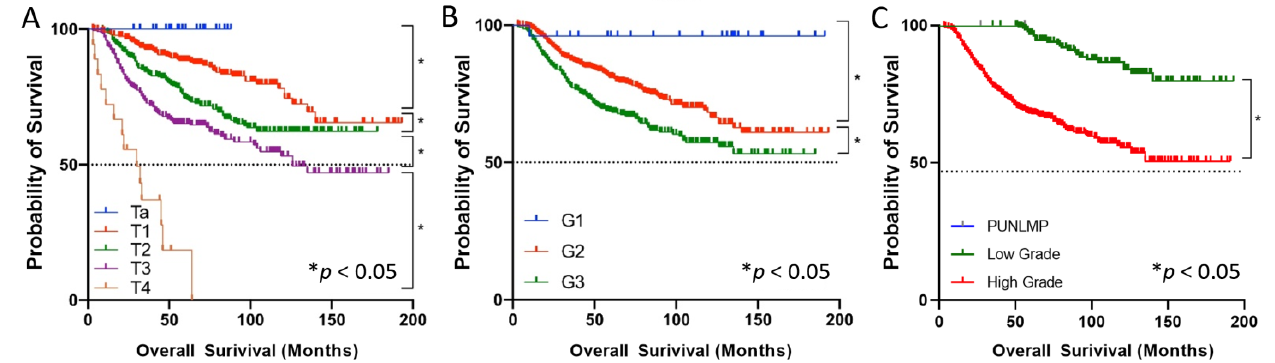
Figure 2. Overall survival curves based on different T-staging and grading in patients with UTUC. ( A ) Overall survival curves based on different T stages. ( B ) Overall survival curves based on the 1973 WHO grading classification. ( C ) Overall survival curves based on the 2004 WHO grading classification. * The overall survival time between the two groups was significantly different.